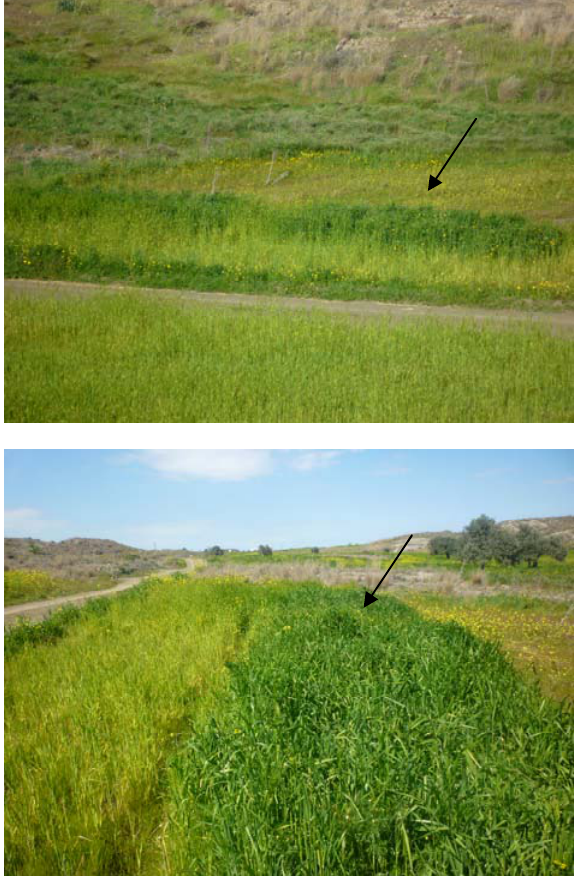
Figure 3. Formation of crop marks in controlled